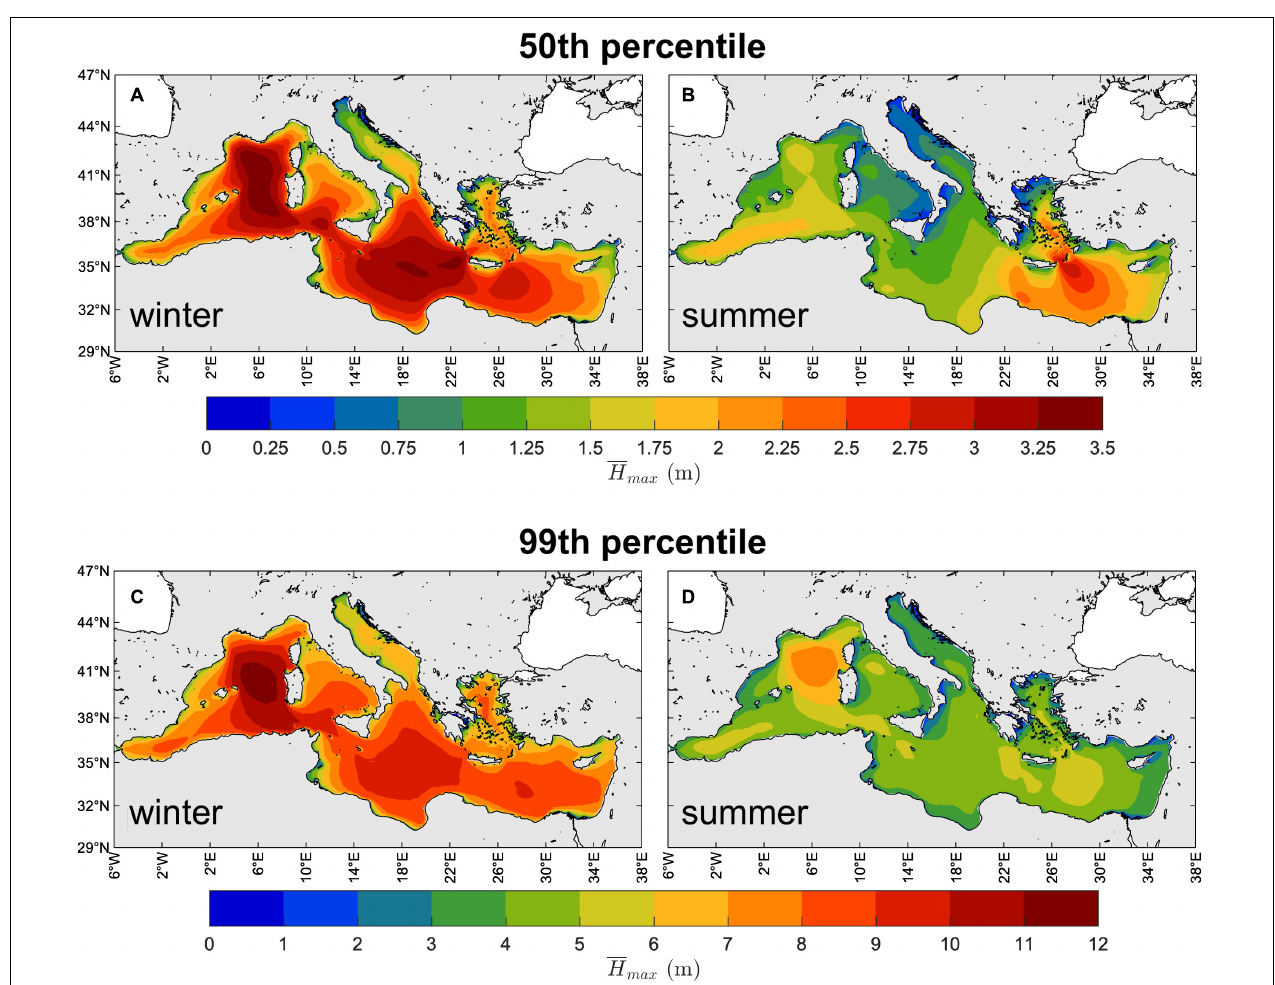
FIGURE 10 | Climate of the maximum individual waves. Yearly-averaged seasonal 50th [panels (A,B) ] and 99th [panels (C,D) ] percentiles of H max (1981–2019): winter [NDJFM, panels (A,C) ], summer [JJA, right panels (B,D) ].